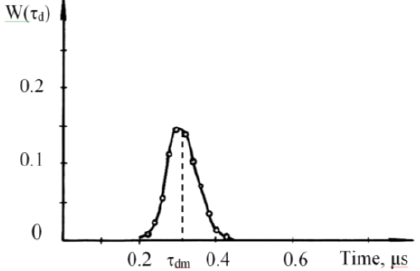
Fig. 5. The law of the distribution of the delay time of i- and (i + 1)-sequences of emitted radio pulses with a stable mode of operation of a super regenerative transceiver ( K b <2.4 ∙10 5 ).